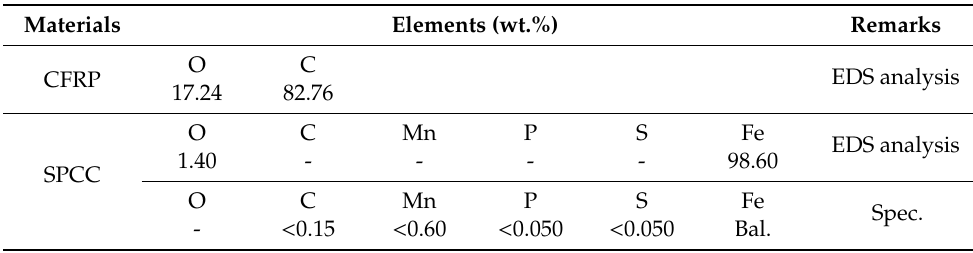
Table 1. Chemical compositions of carbon fiber reinforced plastic (CFRP) and SPCC alloy obtained from EDS